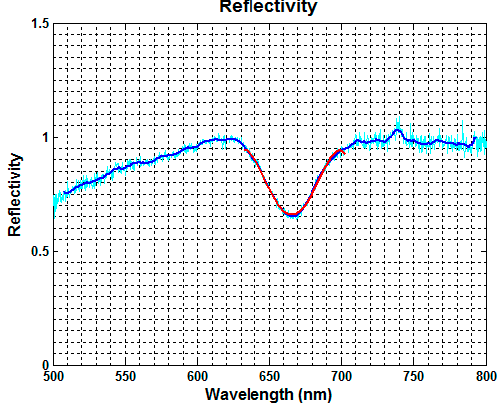
Figure 2. Typical reflectance spectrum showing a dip at λ DIP = 670 nm. Cian: raw data from spectrometer; blue: smoothed data, and red: fitted region to find the minimum.